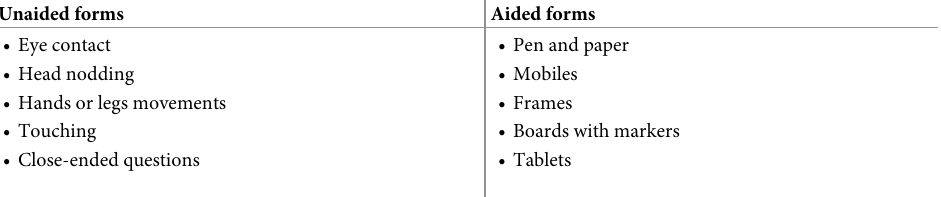
Table 3. Categories and Sub-categories of communication